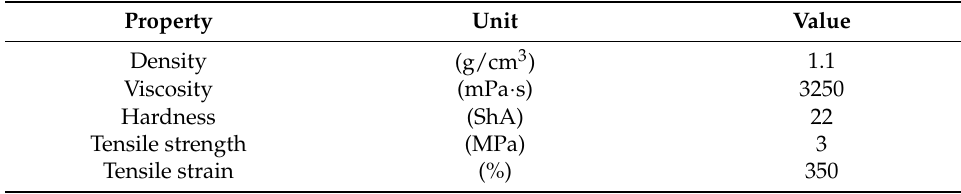
Table 1. Properties of RTV22F silicone [22].